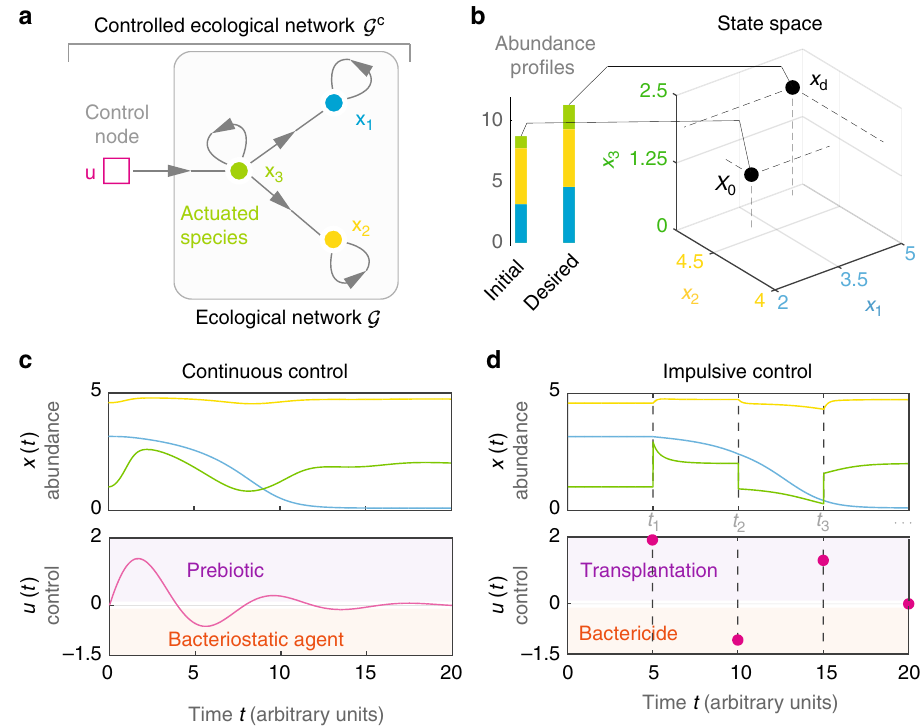
Fig. 1 Controlling a microbial community. a Ecological network G for a toy microbial community of N = 3 species (green, yellow, blue). The controlled ecological network G c contains M = 1 control input actuating the third species. b Initial and desired abundance pro fi les (bars). Controlling the community consists in driving its state from the initial state x 0 to the desired state x d , represented by two points in the state space of the community. c In the continuous control scheme, the control inputs u ( t ) are continuous signals modifying the growth of the actuated species. The controlled population = 5 Þð x = 3 (cid:4) 1 Þ (cid:4) ð 0 : 1 x x = ð 1 þ x = 4 Þð x x = ð 1 þ x dynamics of this community is given by _ x 0 : 1 þ x 1 (cid:4) x , _ x 0 : 1 þ x 1 (cid:4) x 1 Þ þ ð x , 1 ¼ 1 ð 1 1 1 3 Þ 3 Þ 2 ¼ 2 ð 2 2 (cid:4) 2 3 Þ 3 Þ _ x x x = 2 Þð x u . In the absence of control, this community has two equilibria x : 14 ; 4 : 58 ; 1 Þ > and x 4 : 57 ; 4 : 73 ; 2 Þ > , chosen as the 3 ¼ 3 ð 1 (cid:4) 3 3 (cid:4) 1 Þ þ 0 ¼ ð 3 d ¼ ð initial and desired states, respectively. d In the impulsive control scheme, the control inputs u ( t ) are impulses applied at the intervention instants T ¼ f t ; t ; (cid:2)(cid:2)(cid:2)g , instantaneously changing the abundance of the actuated species. The controlled population dynamics is the same as in panel ( c ), 1 2